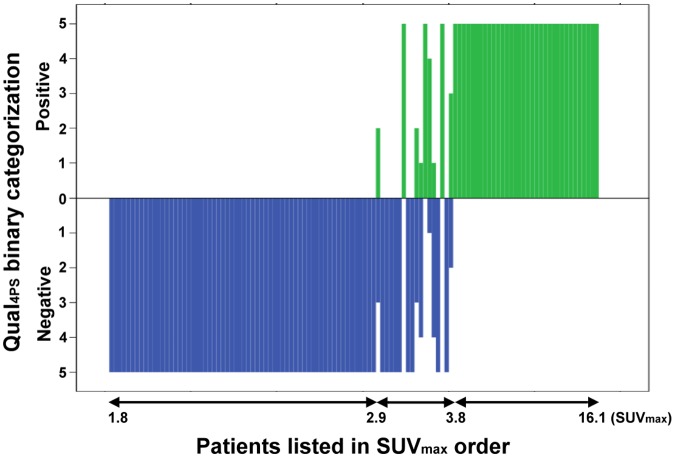
Patients listed by order of SUVmax plots against the number of binary categorization (positive versus negative) by five reviewers using the Qual4PS criterion for post-CRT FDG PET interpretation.